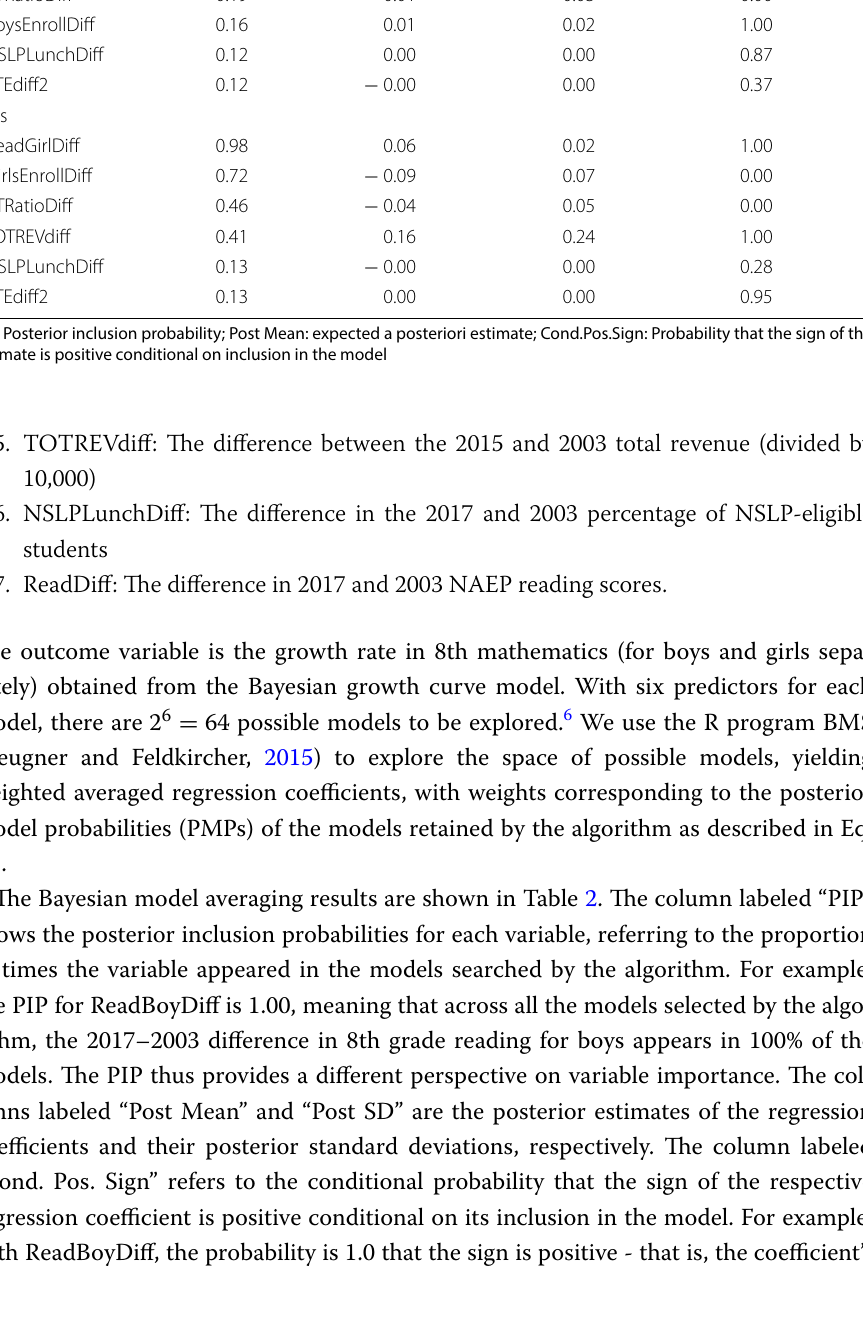
Table 2 Bayesian model averaging results for boys and girls PIP Post Mean Post